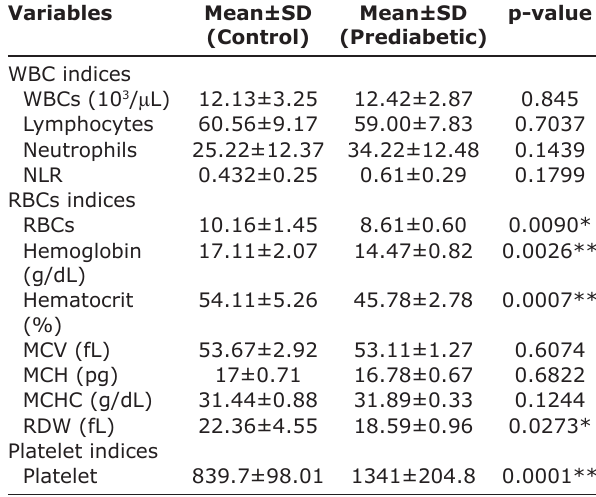
Table-2: Hematological parameters in control and prediabetic